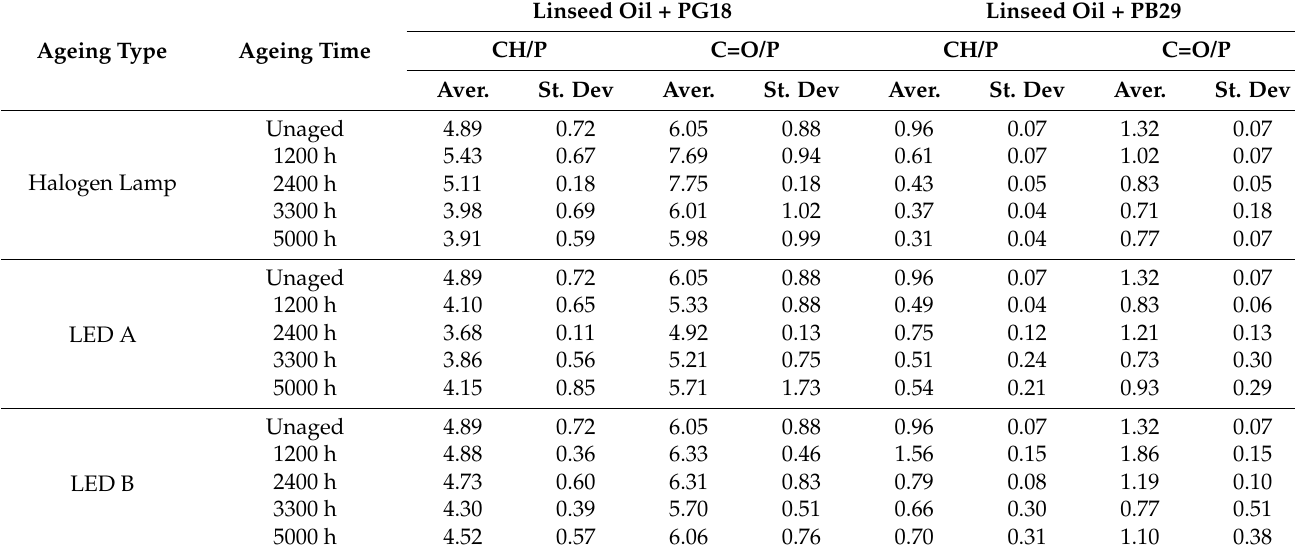
Table 2. Ratios (average—Aver., and standard deviation—St. Dev.) among intensities of CH and C=O IR bands of the linseed oil binder (at 2925 and 1736 cm − 1 , respectively) and IR bands of the chrome green PG18 and ultramarine blue PB29 pigments (P), considered between 583 and 456 cm − 1 and between 775 and 610 cm − 1 , respectively. (LED A: 420 nm, LED B: 460 nm).